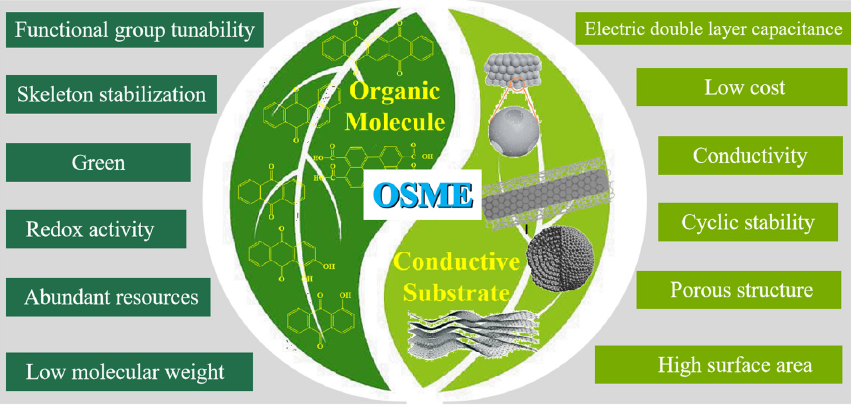
Figure 2. Design motivation and advantages of organic small-molecule electrodes.